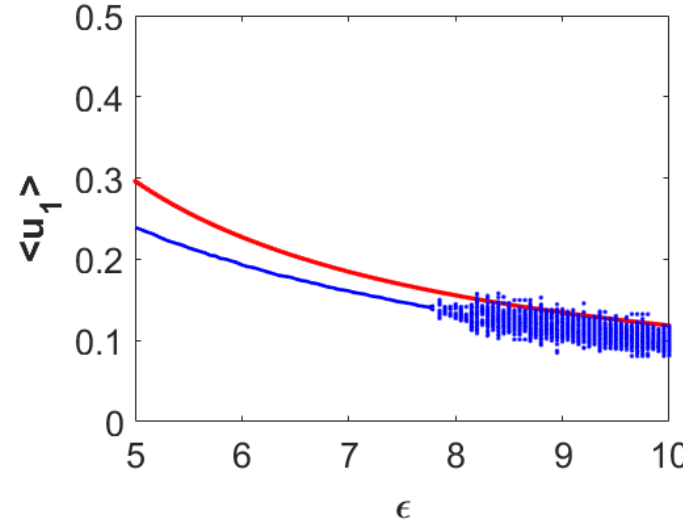
Figure 20. Single parameter bifurcation diagram for the spatially averaged density of first prey population ( < u 1 > ) with respect to the parameter (cid:101) for the nonlocal model (27)–(29). Here, δ 1 = δ 2 = 2.0, d 3 = 1.0 and other parameter values are mentioned in